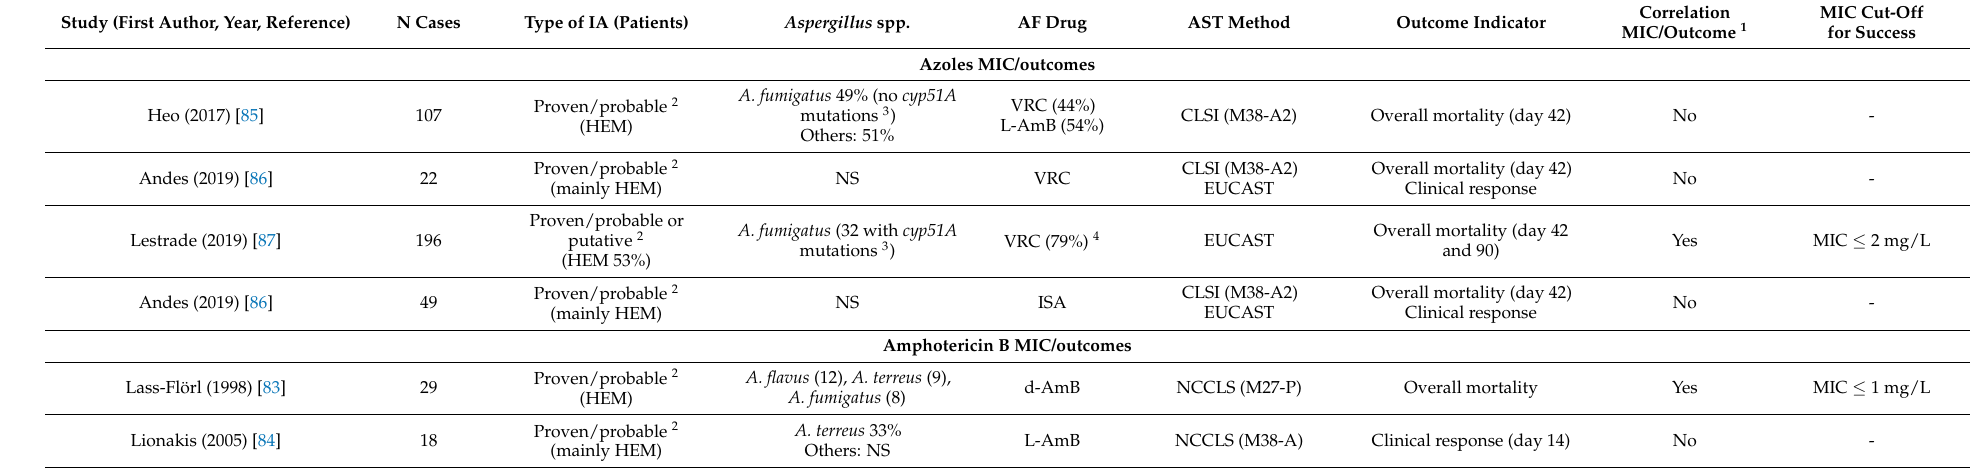
Table 4. Clinical studies correlating antifungal minimal inhibitory concentrations (MIC) and outcome of invasive aspergillosis